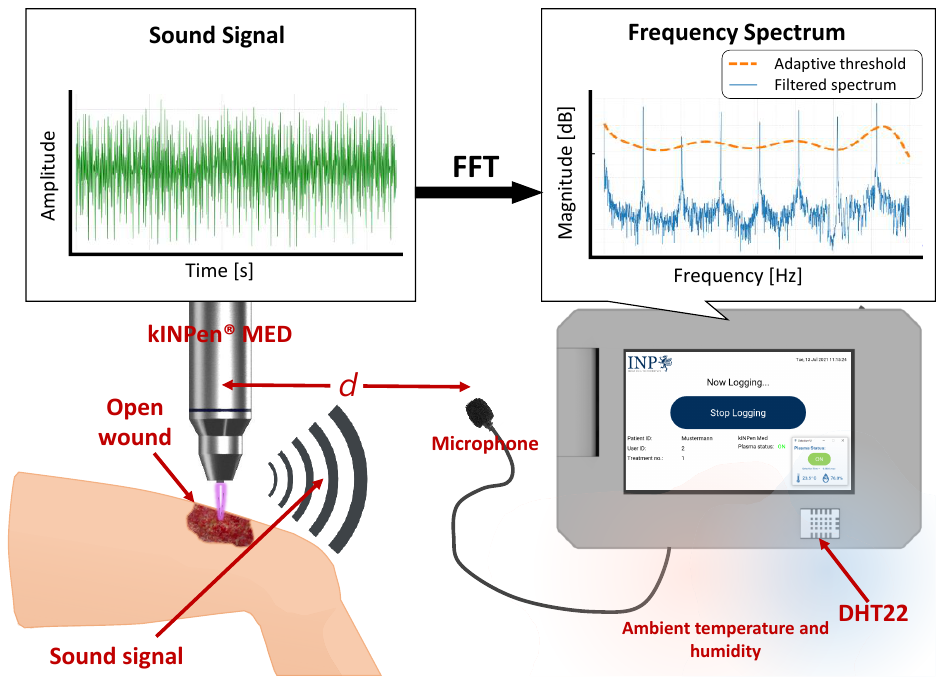
Figure 8. Illustration of the prototype’s working principle with the kINPen ® MED